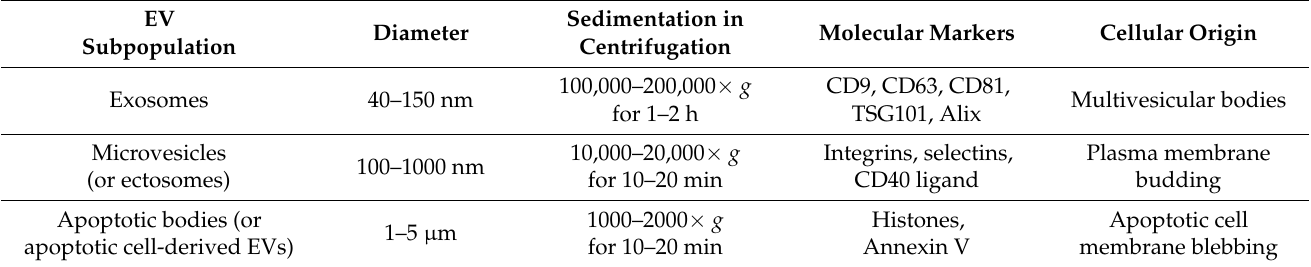
Table 4. EV classification and their biophysical